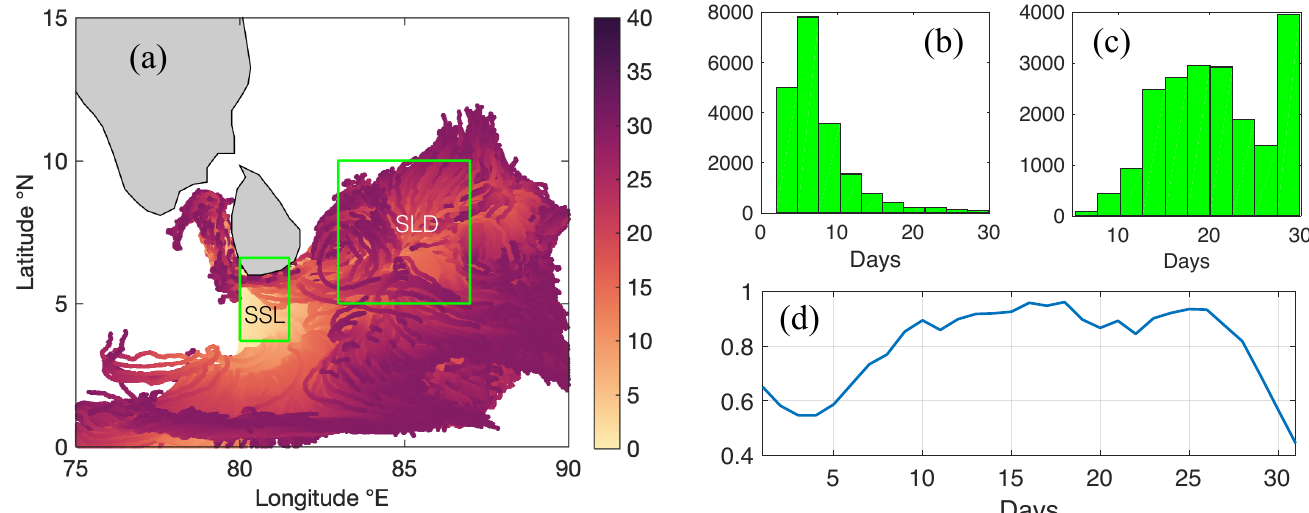
Figure 13. (a) Position distribution of particles released during July 1–30, 2016. The shaded denote the days after each 381 Figure 13. ( a ) Position distribution of particles released during 1–30 July 2016. The shaded areas denote particle is released. (b) Time distribution of particles enters the SLD box. The X-axis denotes the days after particles are 382 the days after each particle is released. ( b ) Time distribution of particles entering the SLD box. The